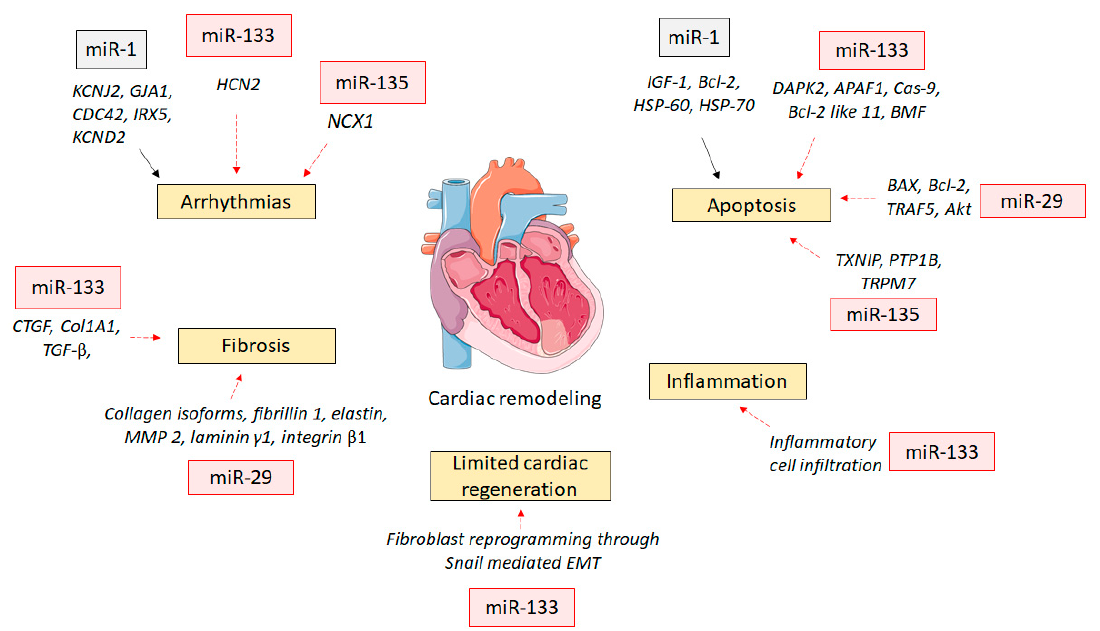
Figure 2. Potential role of miRNAs in positively impacting cardiac remodeling after a myocardial infarction. Akt, protein kinase B; APAF1, apoptotic protease-activating factor 1; BAX, Bcl-2-associated X-protein; Bcl-2, B-cell lymphoma-2; BMF, Bcl-2-modifying factor; Cas-9, caspase-9; CDC42, cell division control protein 42 homolog; COL1A1, collagen 1A1; CTGF, connective tissue growth factor; DAPK2, death-associated protein kinase 2; EMT, endothelial mesenchymal transition; GJA1, gap junction protein alpha 1; HCN2, hyperpolarization-activated cyclic nucleotide-gated ion channel 2; HSP, heat shock protein; IGF-1, insulin-like growth factor-1; IRX5, Iroquois homeobox domain 5; KCND2, Shal-related family member 2; KCNJ2, potassium voltage-gated channel subfamily J member 2; MMP2, matrix metalloproteinase 2; NCX1, sodium– calcium exchanger; PTP1B, protein tyrosine phosphatase 1B; TGF- β , transforming growth factor- β ; TRAF5, tumor necrosis factor-related receptor 5; TRPM7, transient receptor potential melastatin 7; TXNIP, thioredoxin-interacting protein. Black arrow indicates promotion, while red arrow indicates inhibition.